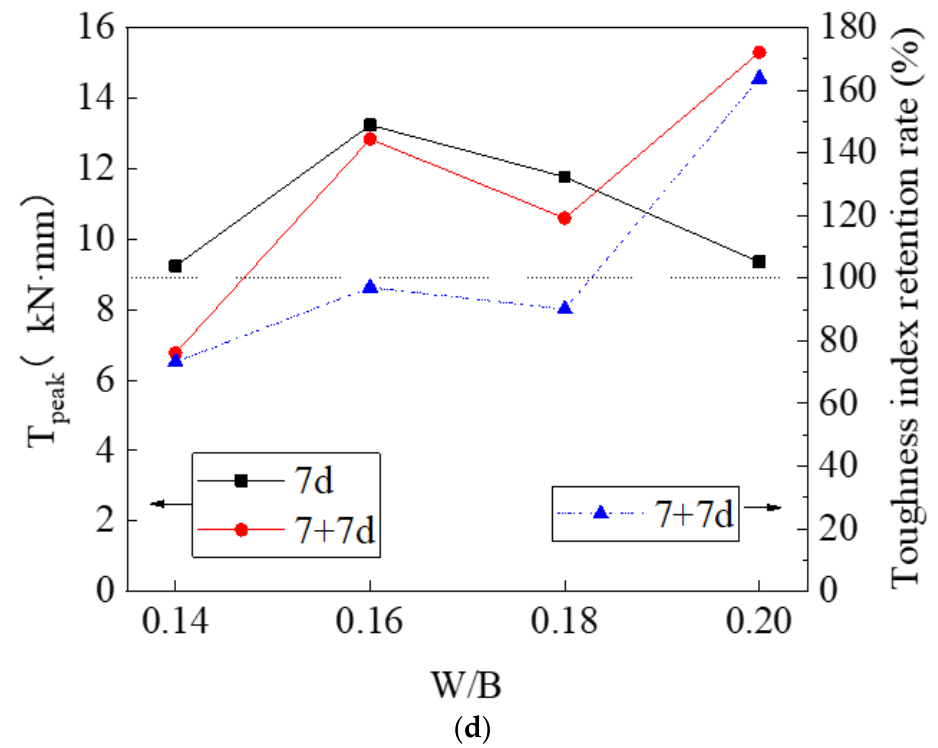
Figure 9. ( a ) First-crack strength, ( b ) ultimate flexural strength, ( c ) ductility index, and ( d ) toughness index, together with their retention rates, of HDMC with different W/B ratios.